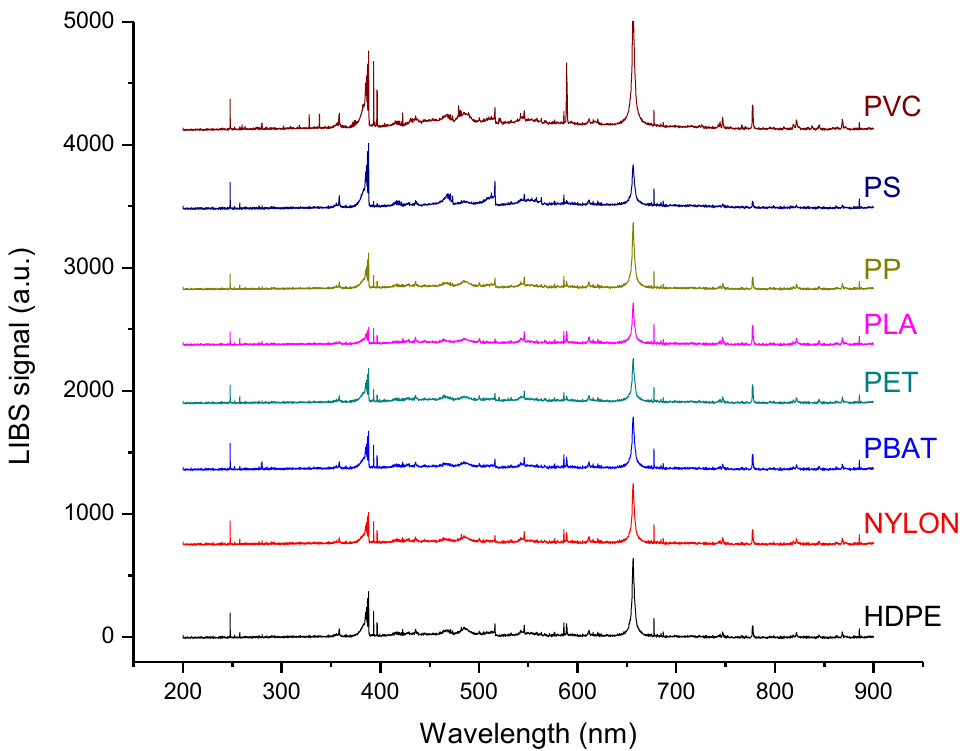
Figure 1. LIBS spectra of the plastic samples (average).